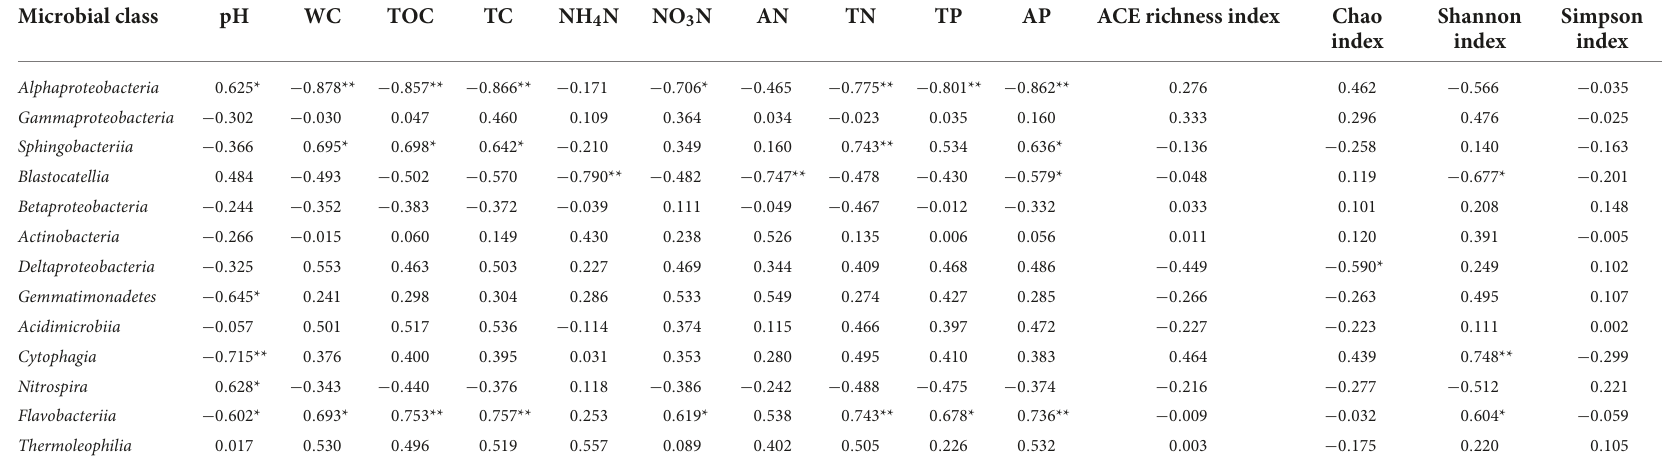
TABLE 4 Correlation between the soil microbial abundance (class level), soil physico-chemical properties and Alpha diversity indices. Microbial